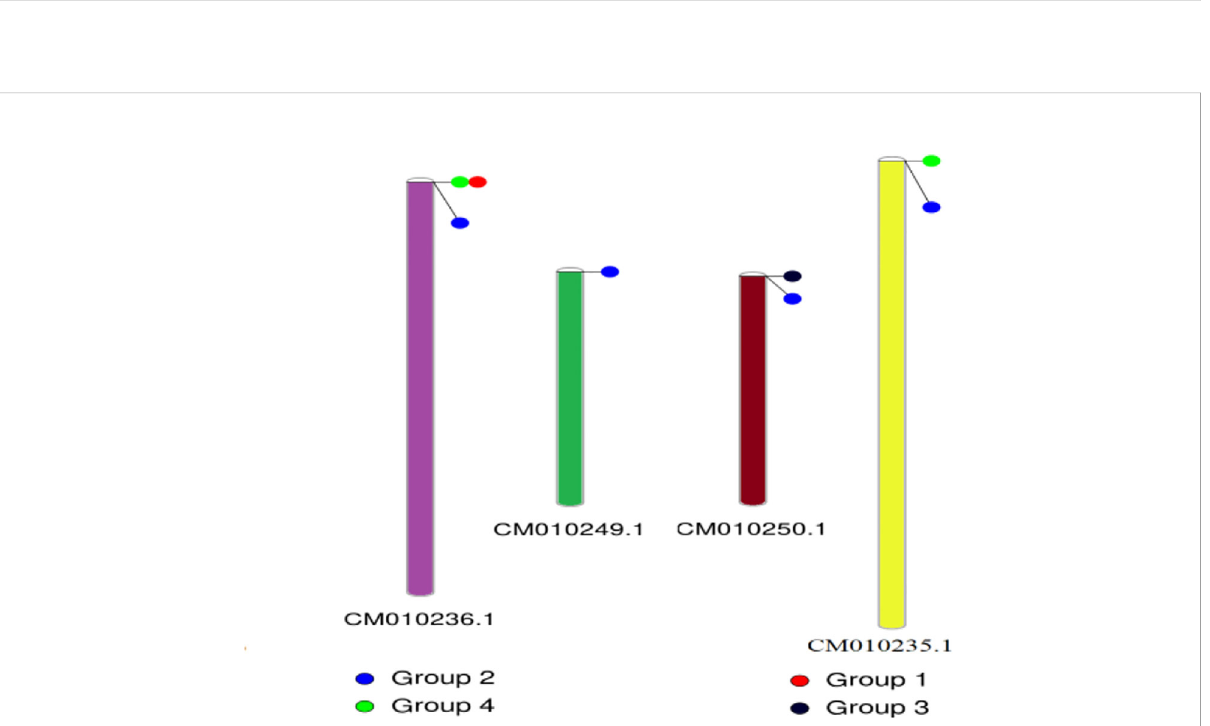
FIGURE 4 Chromosomal location of different transporters. CM010236.1, CM010249.1, CM010250.1 and CM010235.1 represents chromosome number 2, 15, 16 and 1